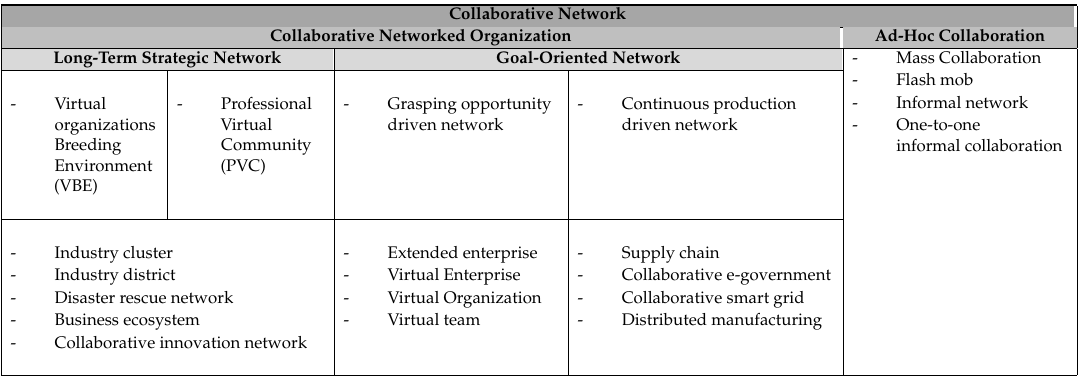
Table 4. Taxonomy of Collaborative Network based on